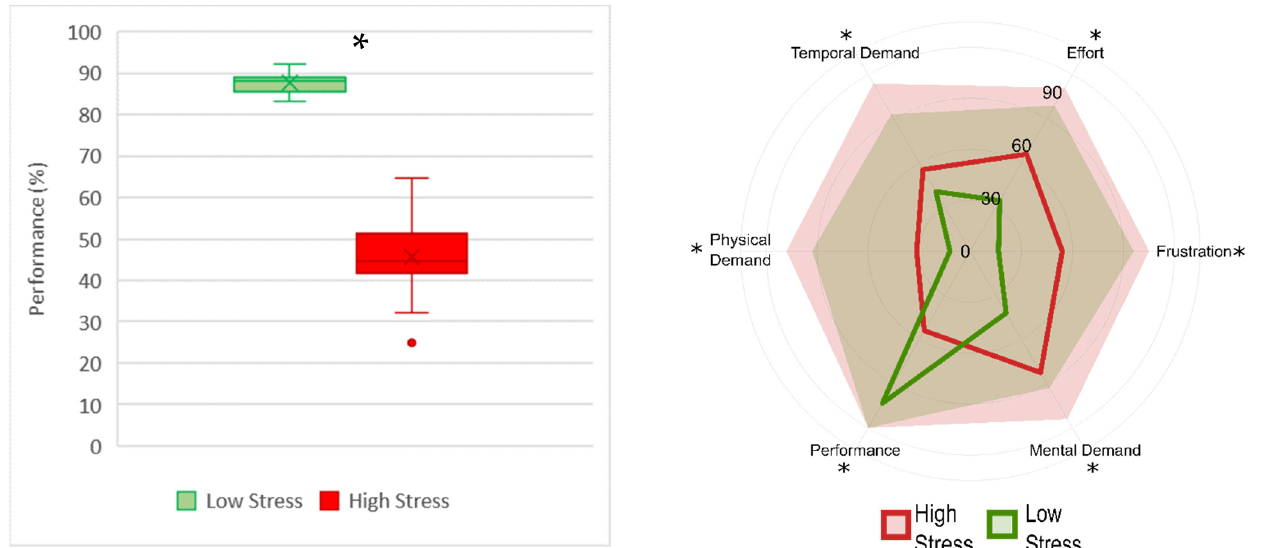
Figure 3. Boxplot representation of the performance in terms of percentage ( left ) and radar chart of NASA-TLX subscales ( right ). In the radar chart, the lines represent the median of each subscale and the shaded areas represent the maximum value in the population. The low-stress condition is represented in green, and high-stress in red. The asterisks show that p < 0.05 resulting from the Wilcoxon signed-rank